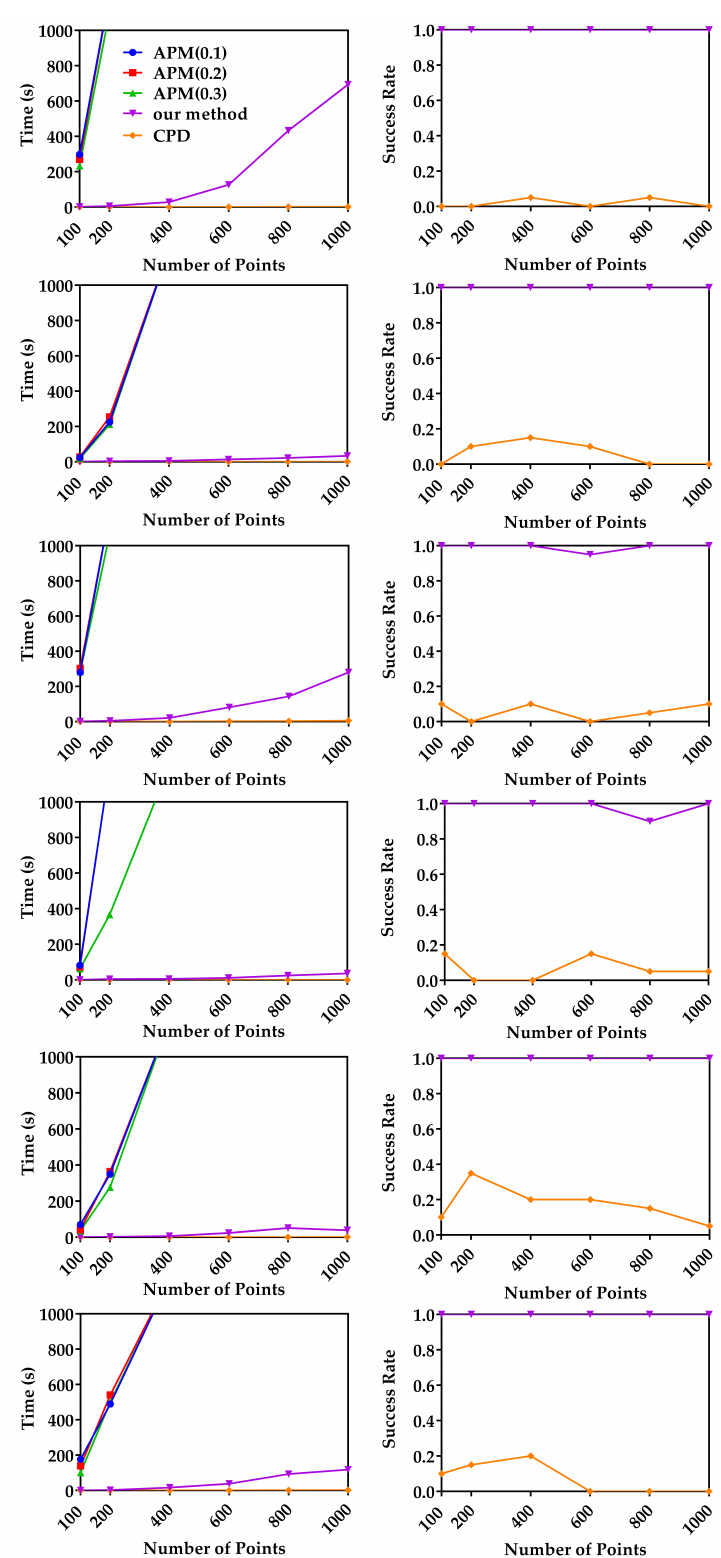
Figure 2. Median runtime and success rate with respective to the number of points. Random data (first row), Archer (2nd row), Chef (3rd row), Kids (4th row), Lucy (5th row) and Owl (last row). Left column: The median runtimes of our method, asymmetric point matching (APM) and coherent point drift (CPD) with respect to the number of points. Right column: The mean success rates of our method and CPD with respect to the number of